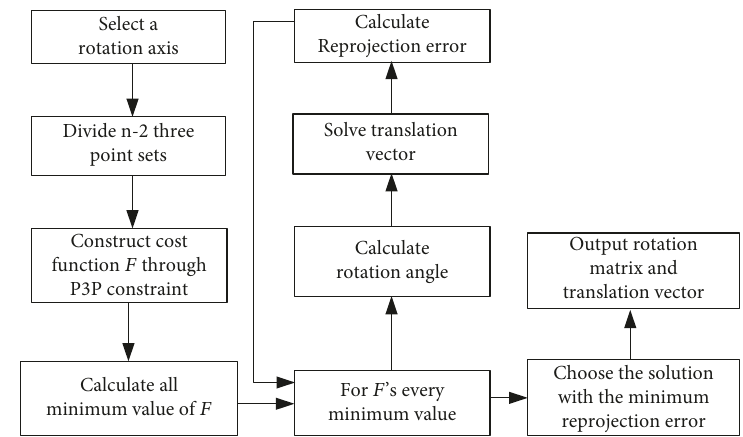
Figure 13: Flowchart of marker recognition.